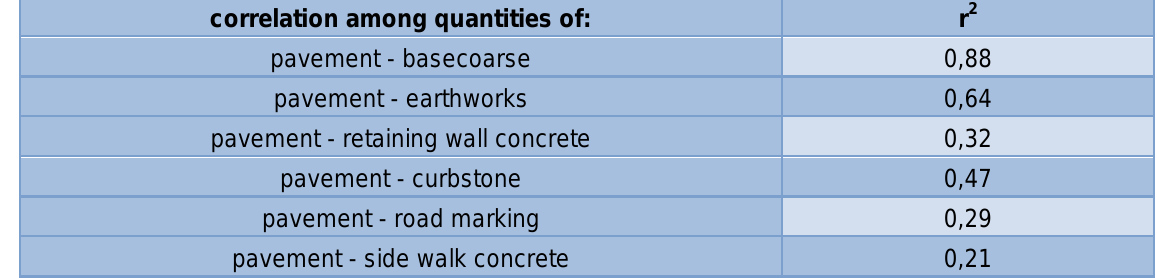
Table 11 Correlation among used input variables